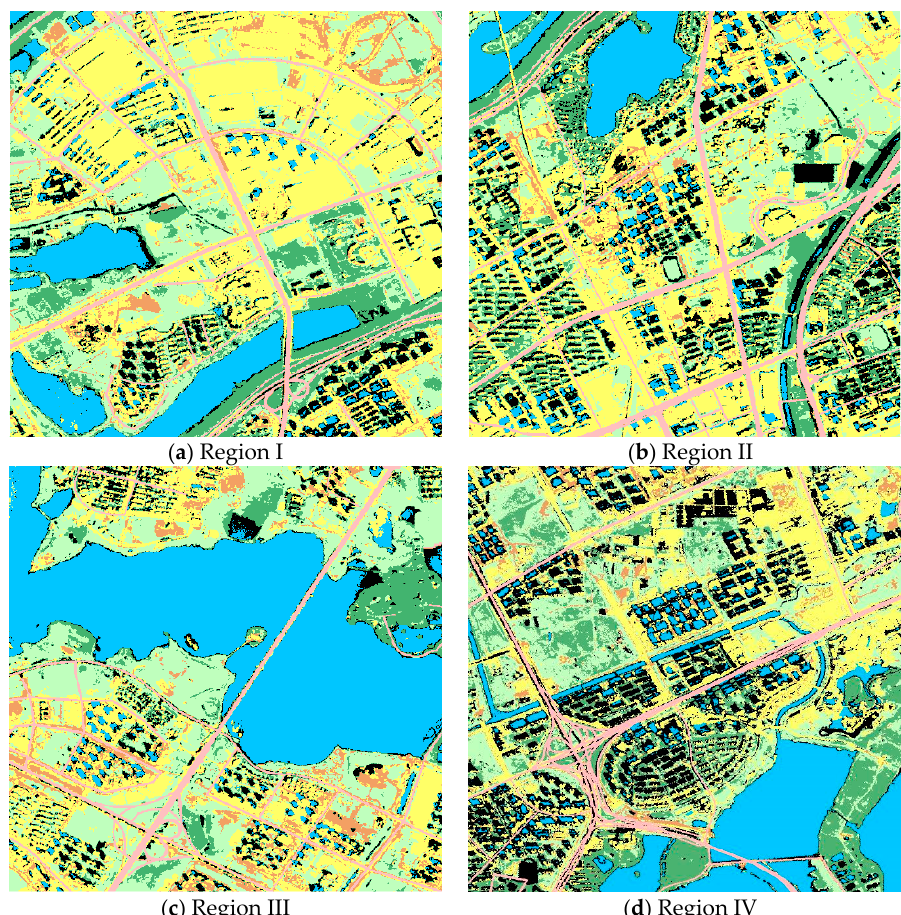
Figure 6. Classification maps of the four test regions provided by the spectral-based approach (yellow = buildings, blue = water, dark green = forests, light green = grasses, pink = roads, orange = soils, and black = shadows). Table 4. The accuracies of the spectral-based classification approach in the four test regions in terms of overall accuracy, Kappa coefficient, and F1-score for each class.